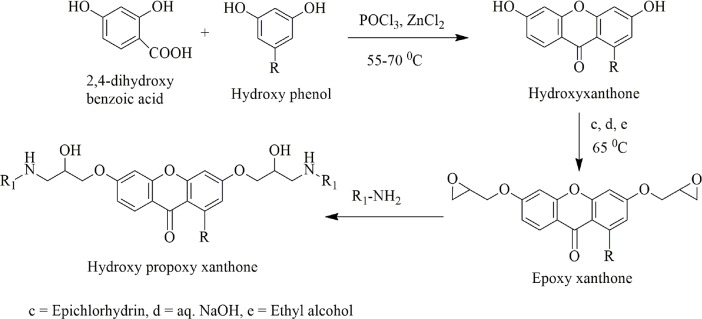
Synthesis of xanthonoxypropanolamines.1a; R = H, R1 = CH2CH2CH3
1b; R = H, R1 = CH (CH3)2
2; R = OH, R1 = CH (CH3)2.